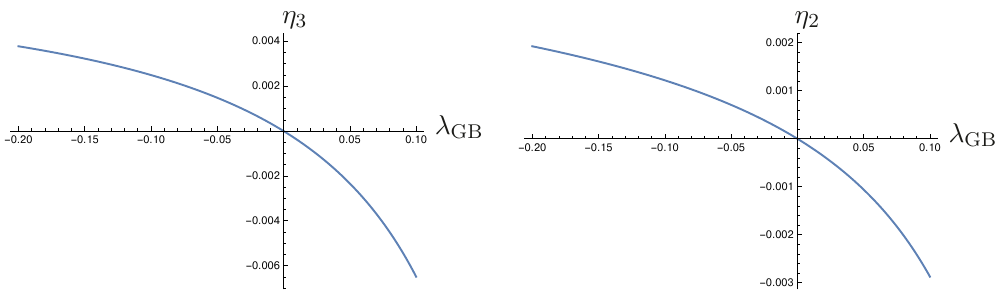
Figure 3 . Corrections to the shear viscosity for the non-conformal GB RG flows induced by dimen- sion ∆ = 3 operator (left panel) and ∆ = 2 operator (right panel). See (3.5) for the parameterization of the